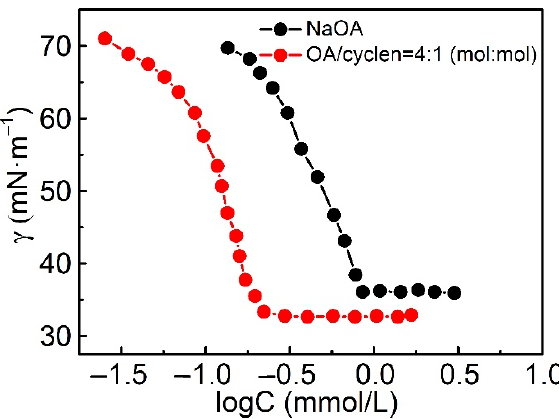
Figure 2. Plot exhibiting the variation in the surface tension with concentration for NaOA and OA/cyclen (mol/mol, 4:1) at 25 °C, where the concentration of OA/cyclen refers to the concentration of OA in OA/cyclen.